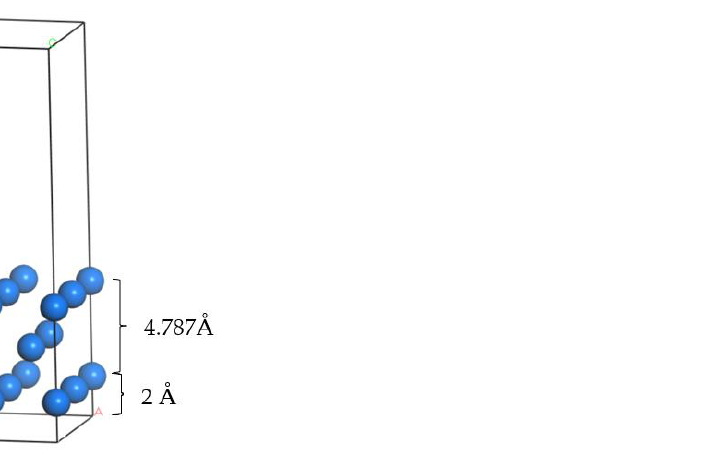
Figure 2. A surface model of δ -Pu (100). (A, B, C are the direction of coordinate axis, same below).